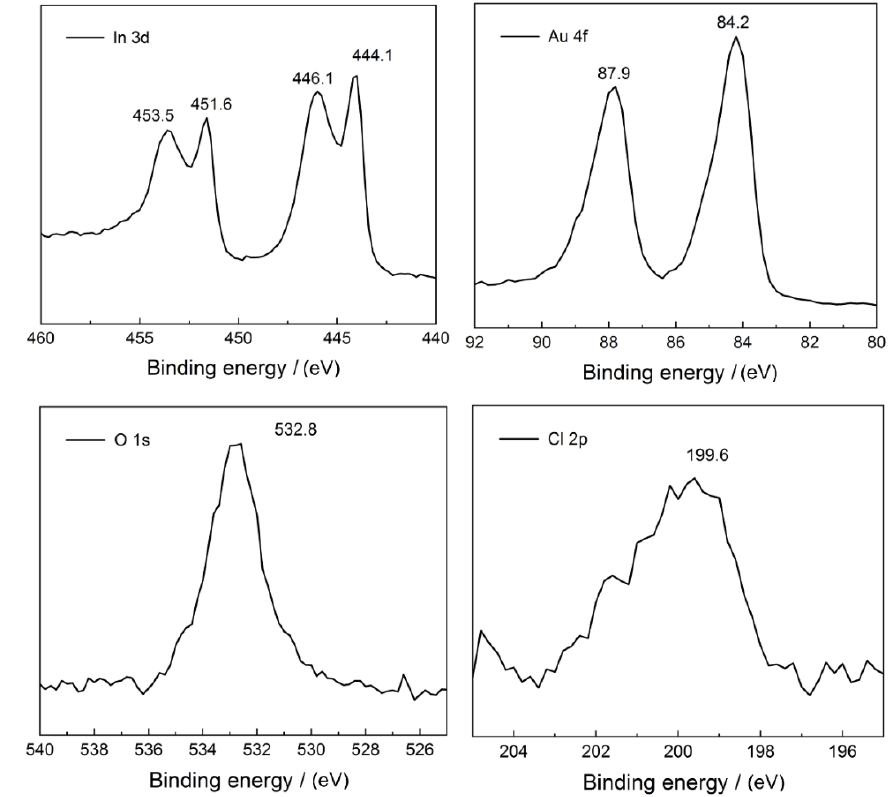
Figure 9. Ex situ XPS spectra of In 3d, Au 4f, O 1s, and Cl 2p of the In deposits after washing with acetone.